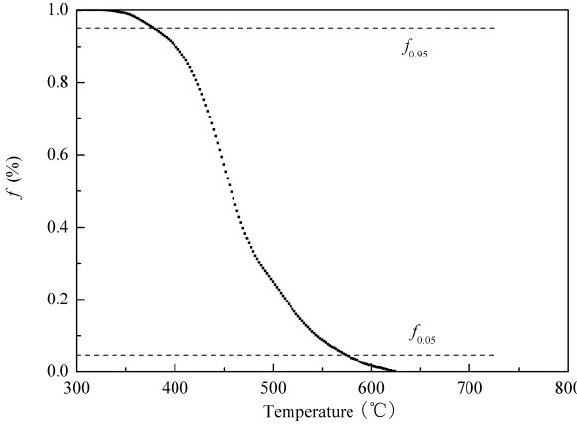
Figure 4. Change of phase transformation f with temperature.